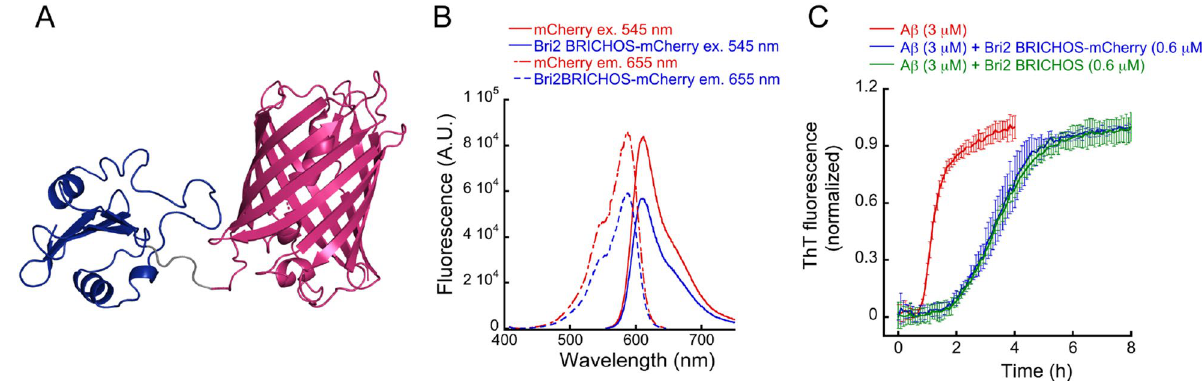
Figure 1. ( A ) Depiction of schematic Bri2 BRICHOS-mCherry structure. Bri2BRICHOS structure model 19